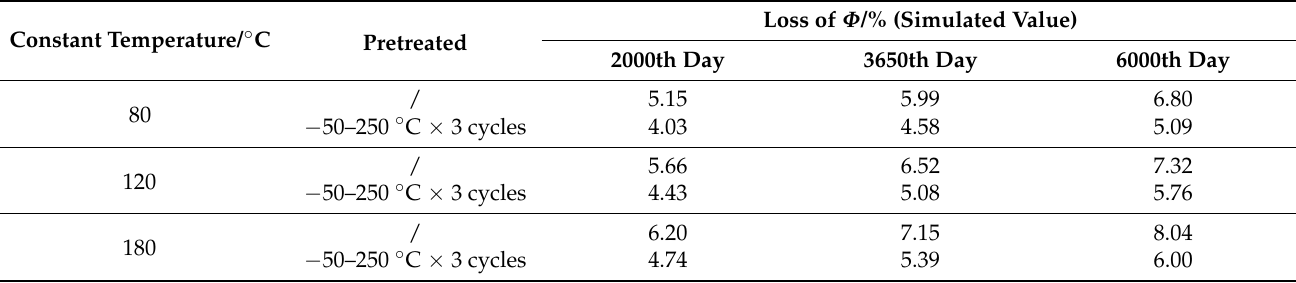
Table 5. Simulation results of the losses of Φ in the different constant temperatures after the 2000th, 3650th, and 6000th days by using the fitting parameters as shown in Table 4.